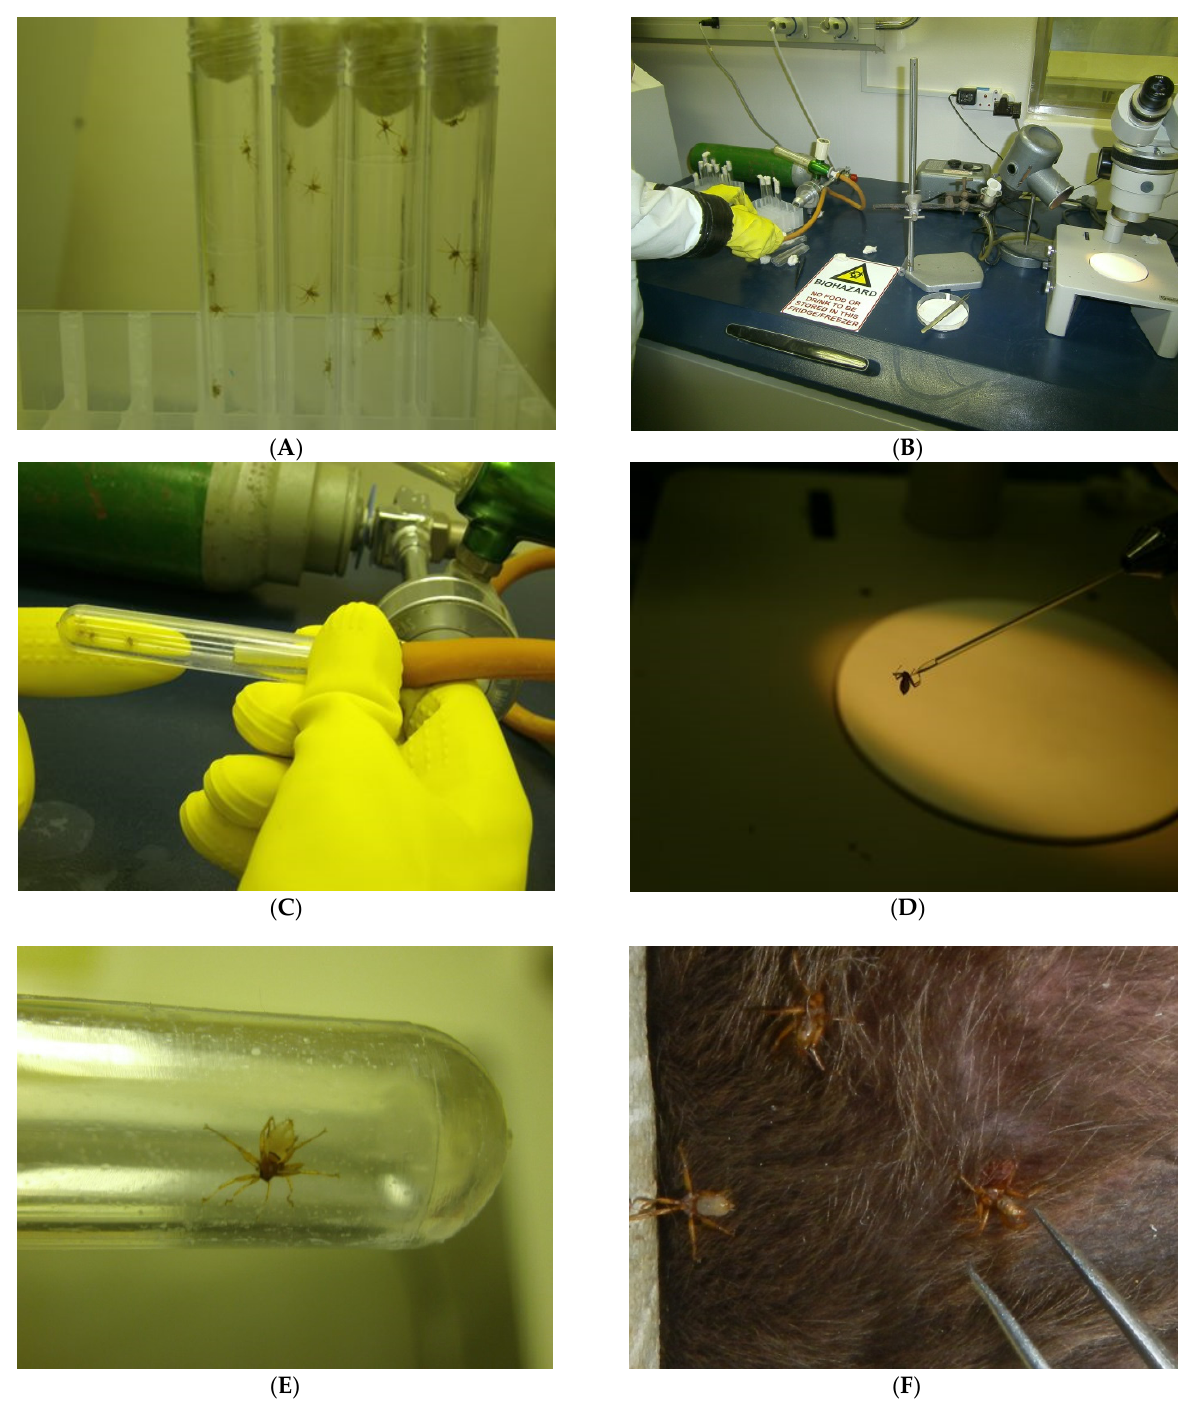
Figure 7. Experiment II. Number, sex of bats, and the number of bat MARV ‐ inoculated flies released on seronegative Egyptian rousette bats. B = Bat identification number 36–53; Green outline = Female; Blue outline = Male; number on the bat = Number of MARV ‐ inoculated flies released on each bat.